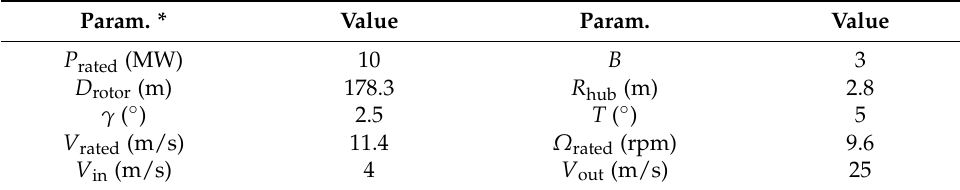
Table 1. Main parameters of the DTU 10 MW wind turbine. Param. * Value Param. Value P rated (MW) 10 B 178.3